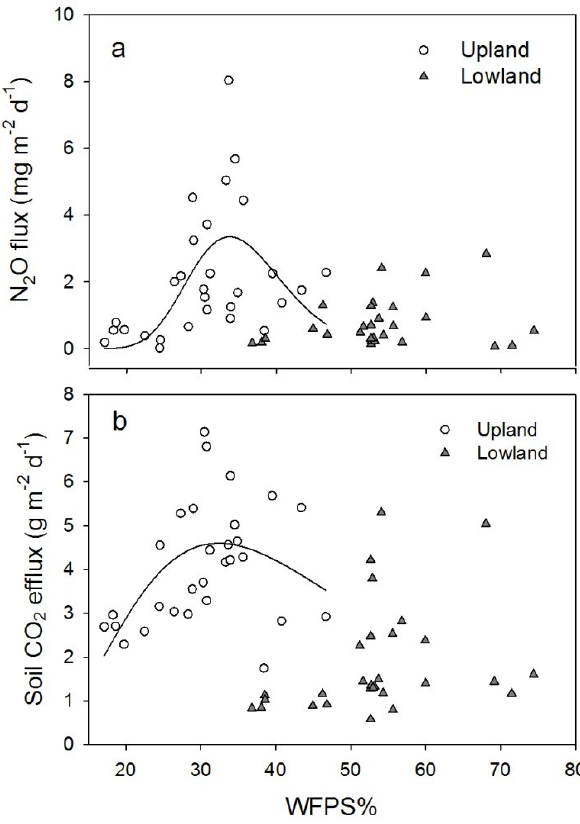
Fig. 4. N 2 O and CO 2 daily average fluxes plotted versus values of soil WFPS. The regression lines are lognormal fits of uphill data set of N 2 O ( (a) R 2 = 0 . 31, P = 0 . 007, DF = 29) and CO 2 ( (b) R 2 = 0 . 26, P = 0 . 02, DF = 29)